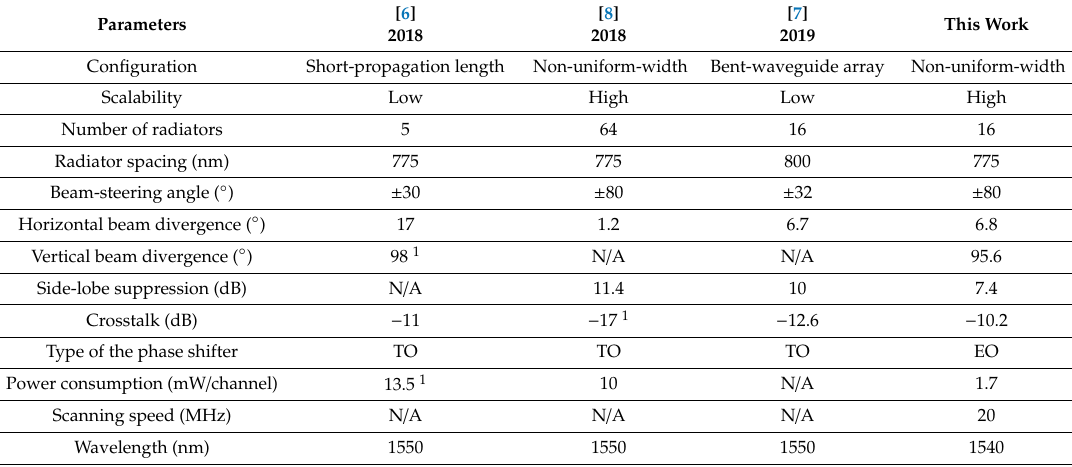
Table 1. Performance comparison of near half-wavelength pitch